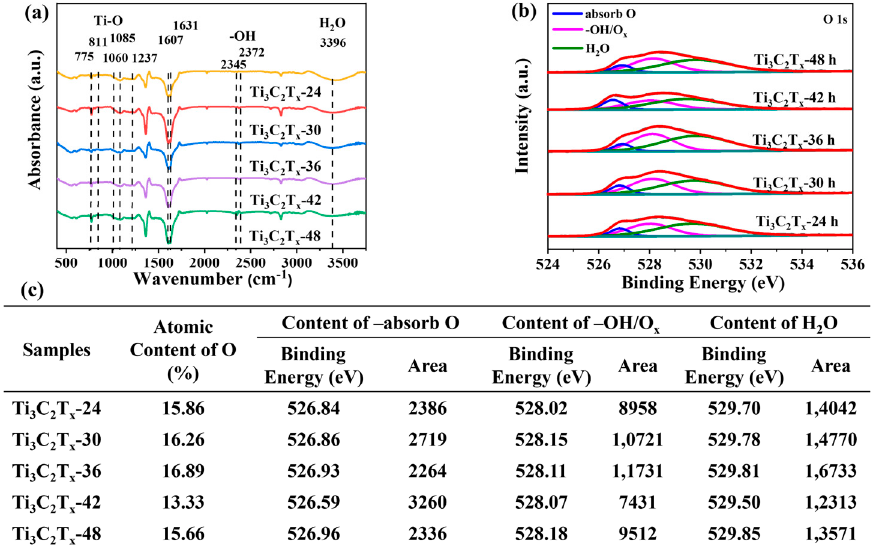
Figure 4. ( a ) FTIR spectra, ( b ) High-resolution XPS spectra of O 1s, ( c ) Table of different O group comparison of Ti 3 C 2 T X -24, Ti 3 C 2 T X -30, Ti 3 C 2 T X -36, Ti 3 C 2 T X -42 and Ti 3 C 2 T X -48.